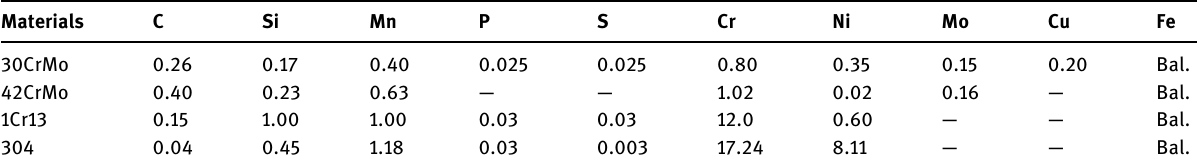
Table 1: Chemical compositions of 30CrMo steel, 42CrMo steel, 1Cr13 steel, and stainless steel 304 in wt% Materials